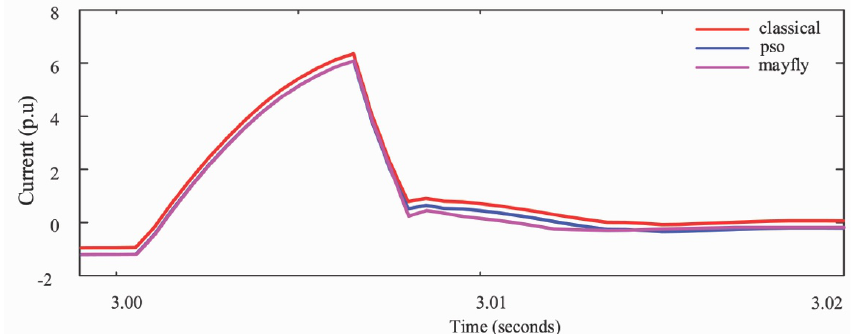
Figure 19. Fault introduction at gird side 2.